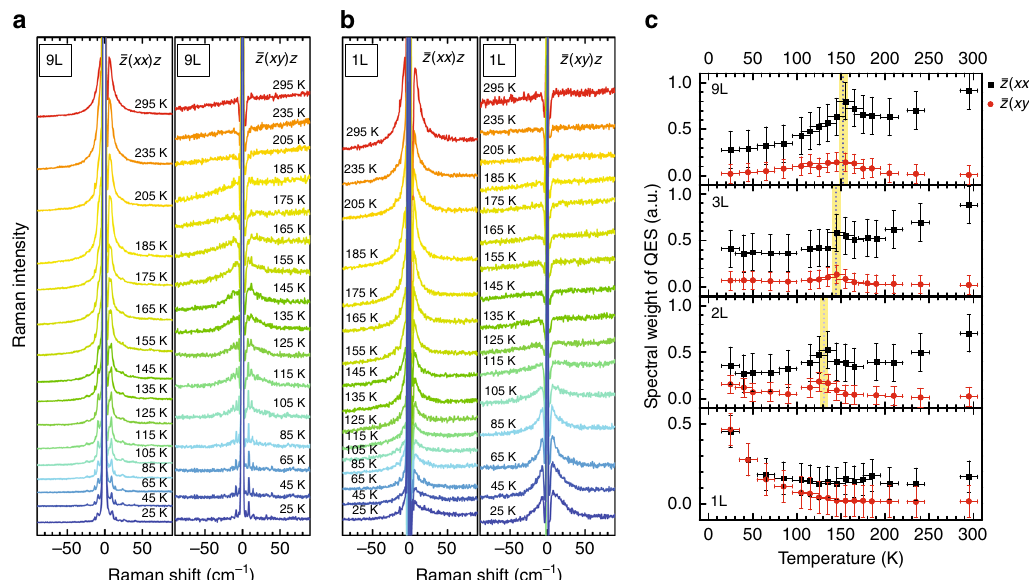
Fig. 6 Temperature dependence of quasi-elastic scattering signals. a , b Low-frequency polarized Raman spectra of 9L ( a ) and monolayer ( b ) NiPS 3 . c Spectral weight of QES between 11 and 40cm – 1 as a function of temperature for various thicknesses for parallel (black squares) and cross (red circles) polarization scattering con fi gurations. The error bars indicate experimental uncertainties and dashed lines show estimated transition temperatures by using Δ P